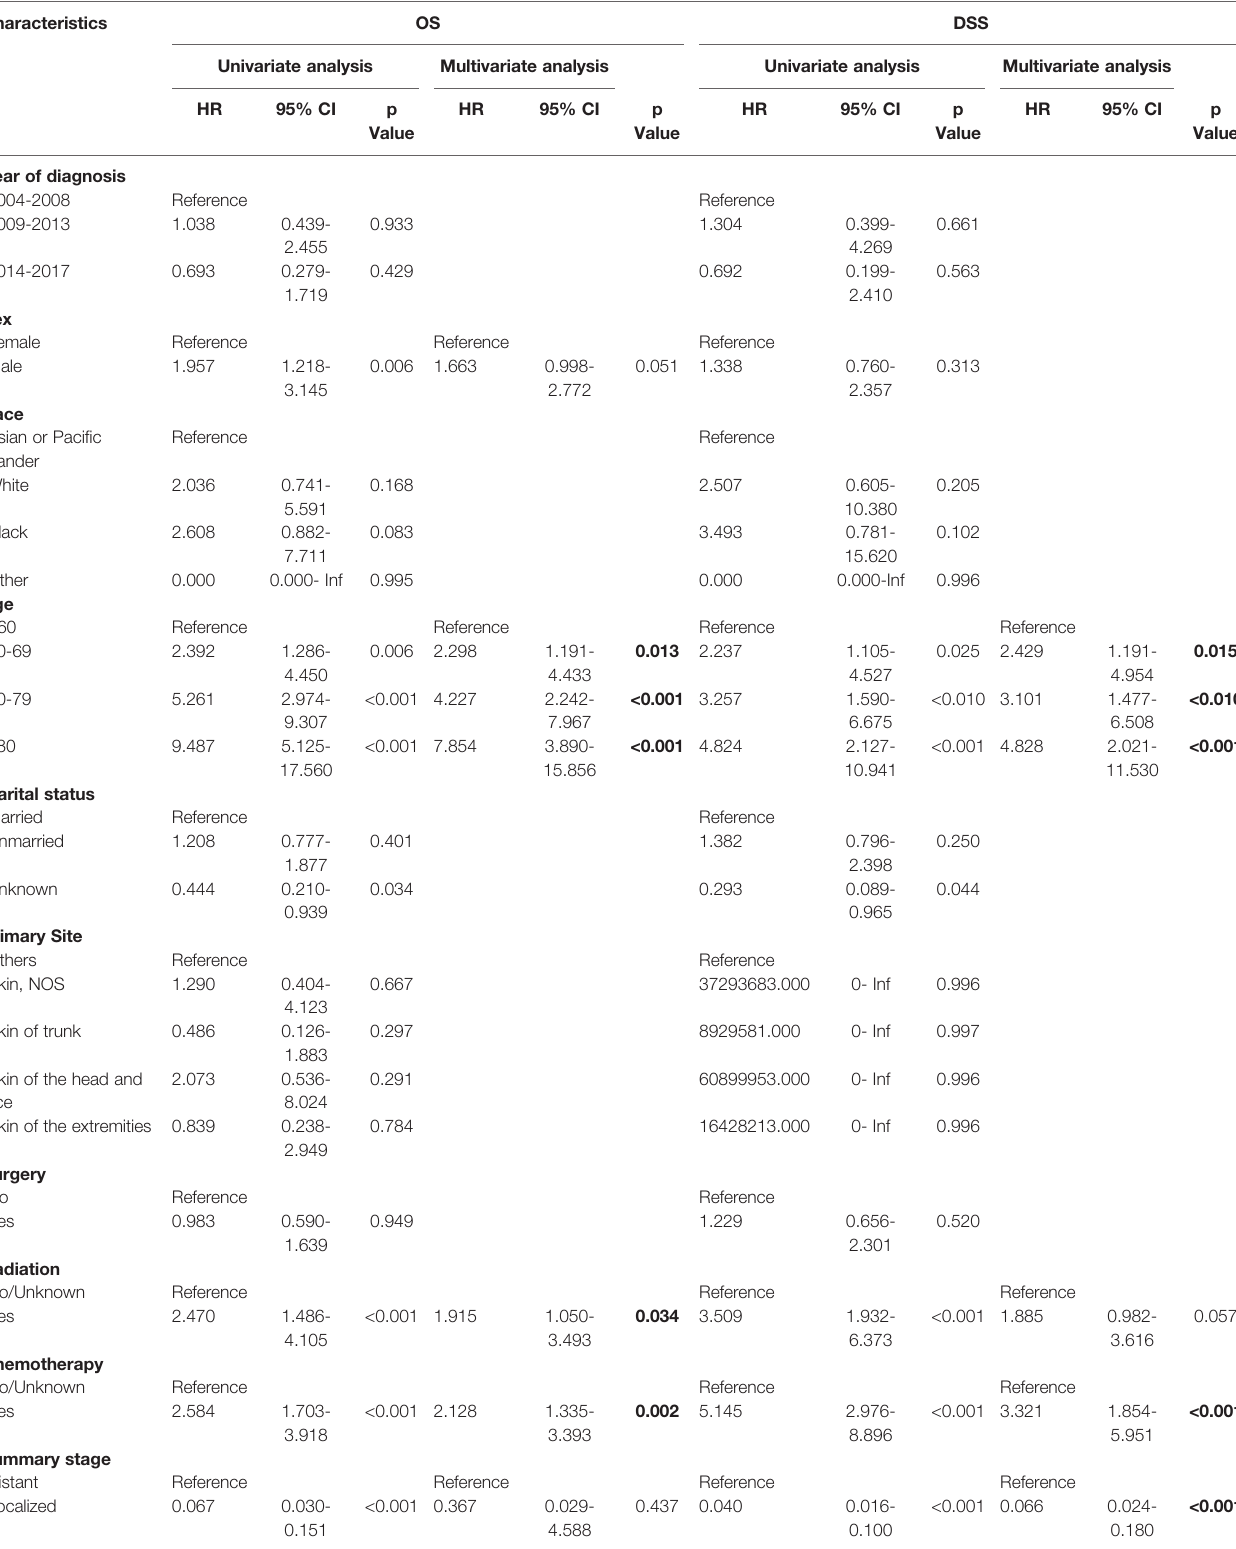
TABLE 2 | Univariate and multivariate Cox regression analysis of OS and DSS in patients with HIV-associated CTCL in training cohort. Characteristics OS DSS Univariate